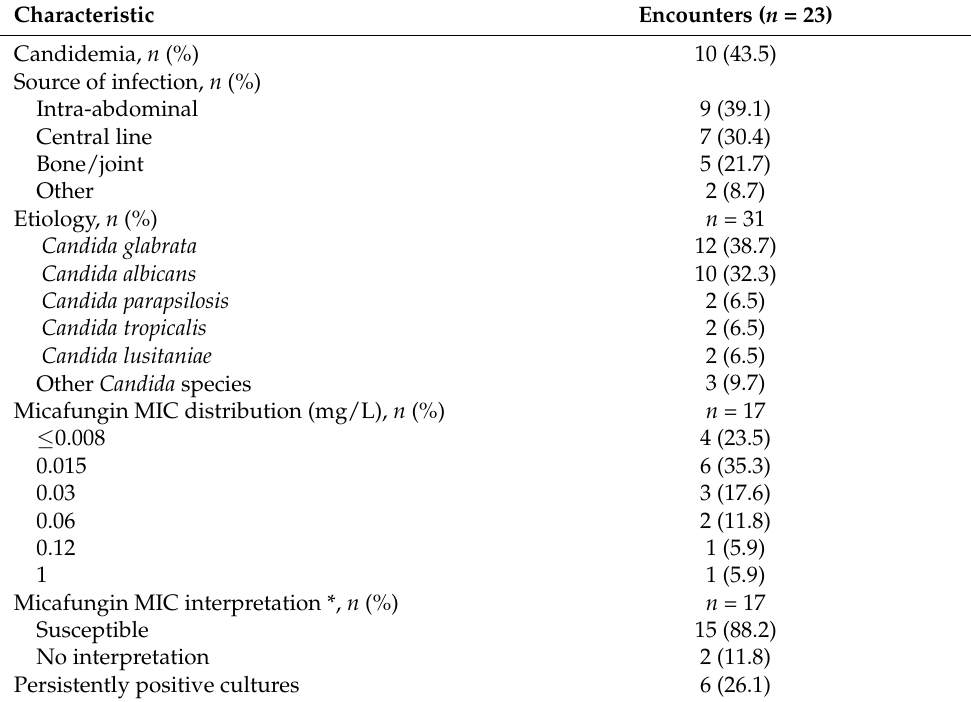
Table 2. Microbiology data.